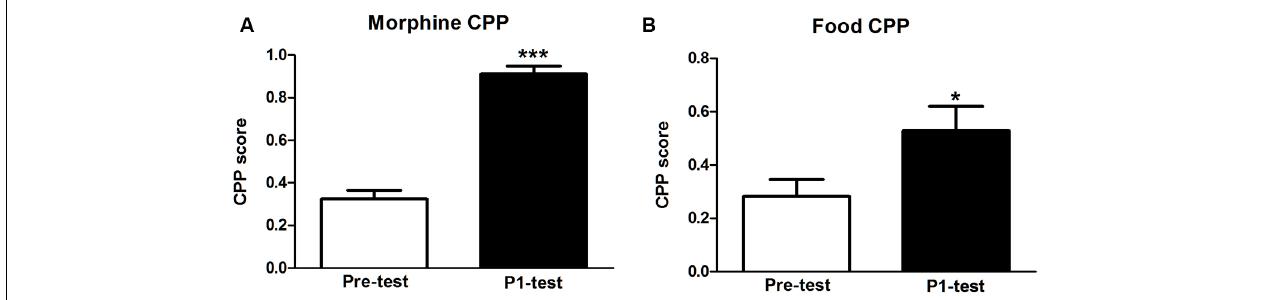
FIGURE 1 | Establishment of morphine and food CPP in tree shrews. (A) Morphine conditioned tree shrews showed a significant preference for morphine-paired chamber. (B) Tree shrews in food group showed a significant preference for food paired chamber. Blank and solid columns represent data from pre- and P1-tests, respectively. Data were expressed as the means ± SEM, n = 4. ∗ p < 0.05, ∗∗∗ p < 0.001.